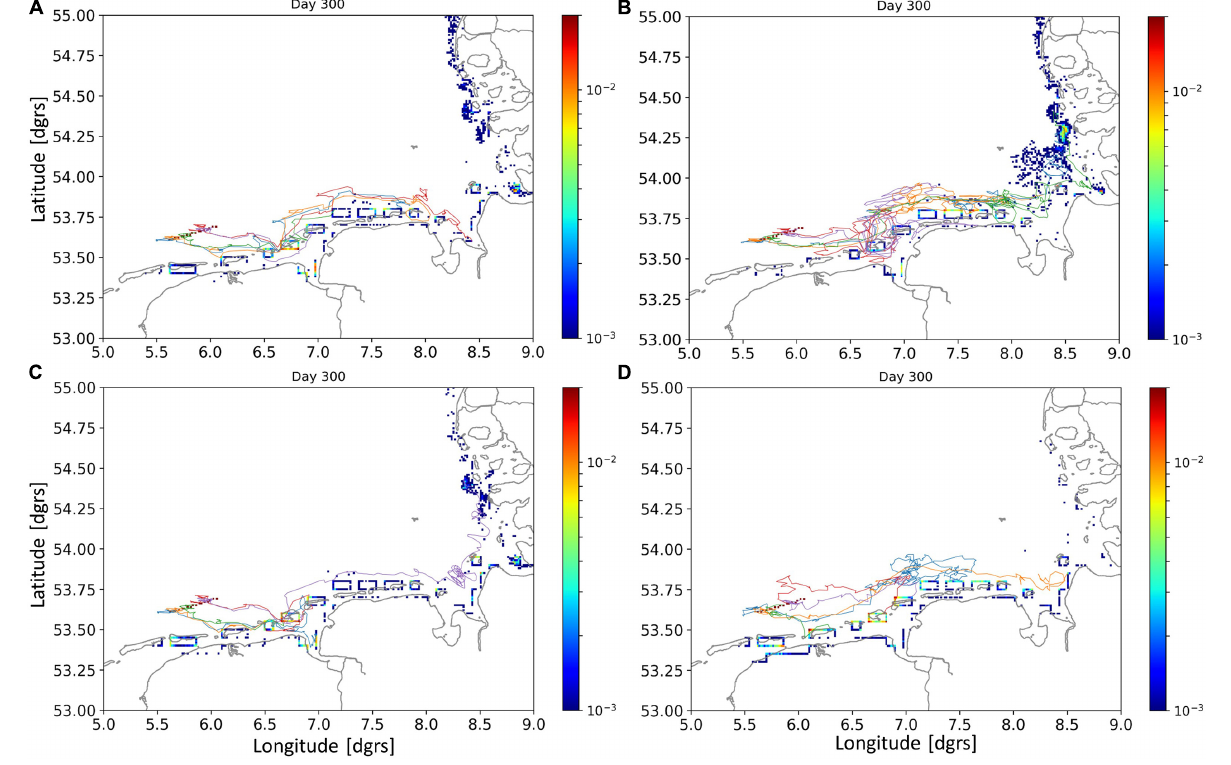
FIGURE 10 | Sensitivity of the results for PS grains for the third part of the trajectory. (A) As Figure 9 c; (B) with vertical velocity of − 0.0015 ms − 1 ; (C) with vertical velocity was − 0.006 ms − 1 ; (D) with a horizontal diffusion coefficient of 12 m 2 s − 1